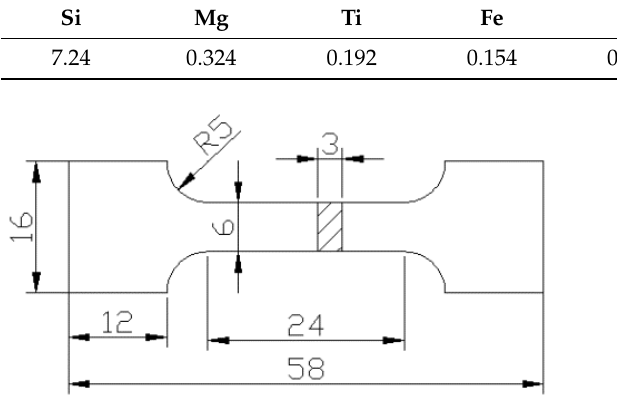
Table 1. Chemical composition of Al-7.0Si-0.3Mg alloy (mass fraction, %). Si